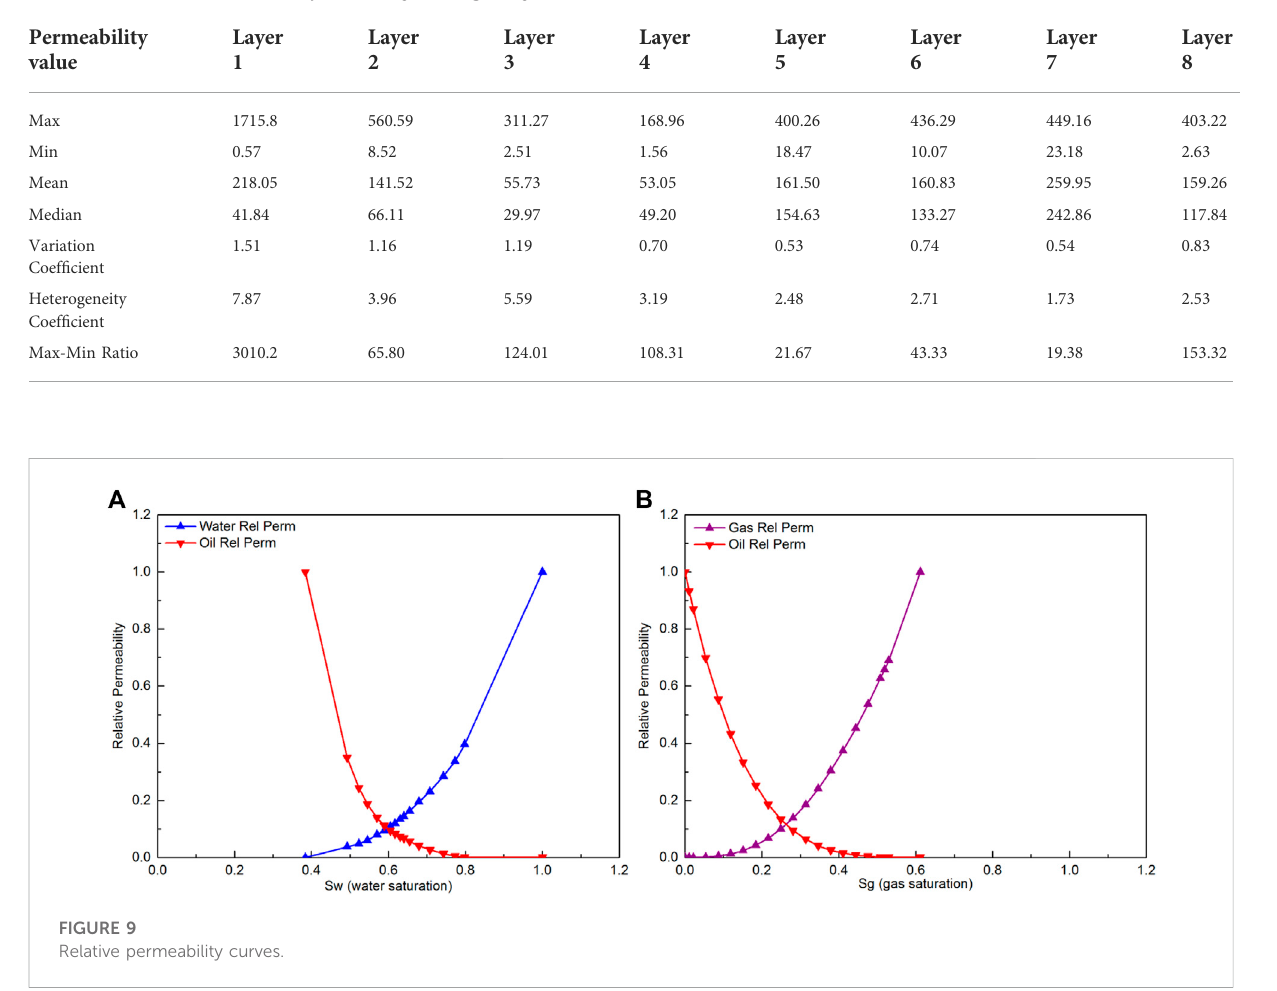
TABLE 4 Characteristics of lateral permeability heterogeneity.